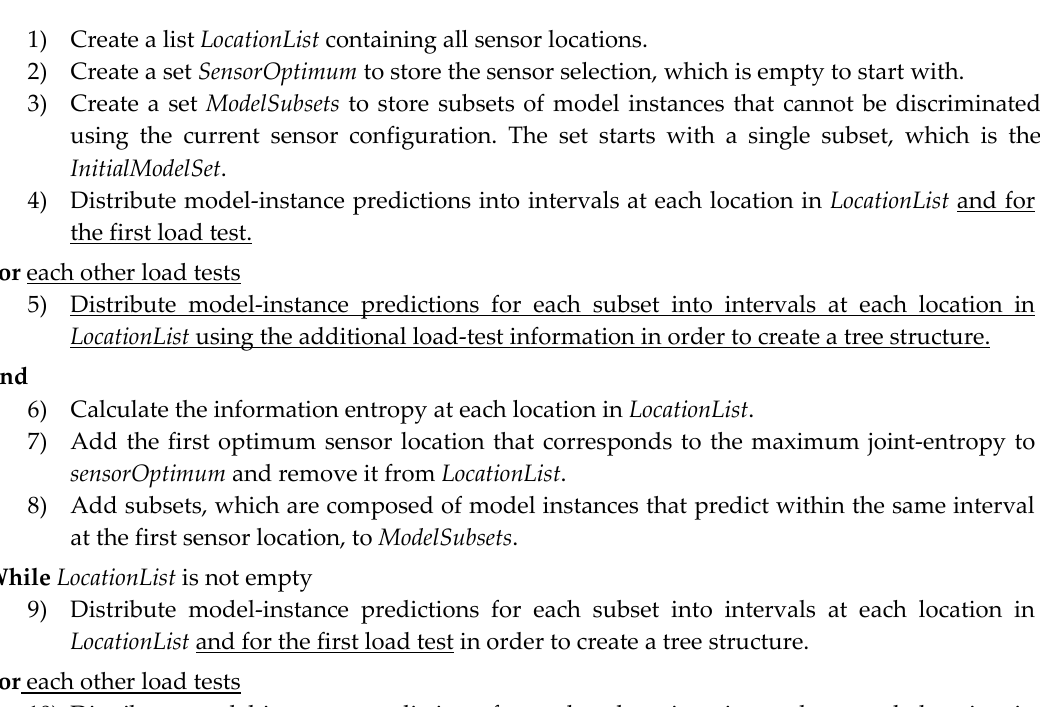
Pseudo code of the new hierarchical algorithm for multiple load tests